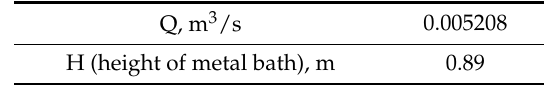
Table A1. Process parameters.